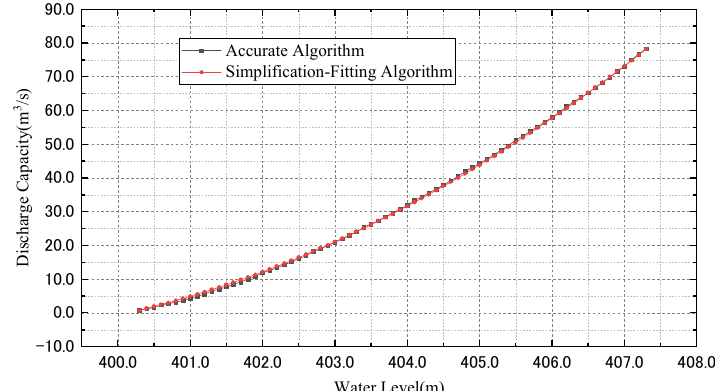
Figure 5. Figure on discharge capacity results from both simplified and accurate algorithms in the free discharge stage.